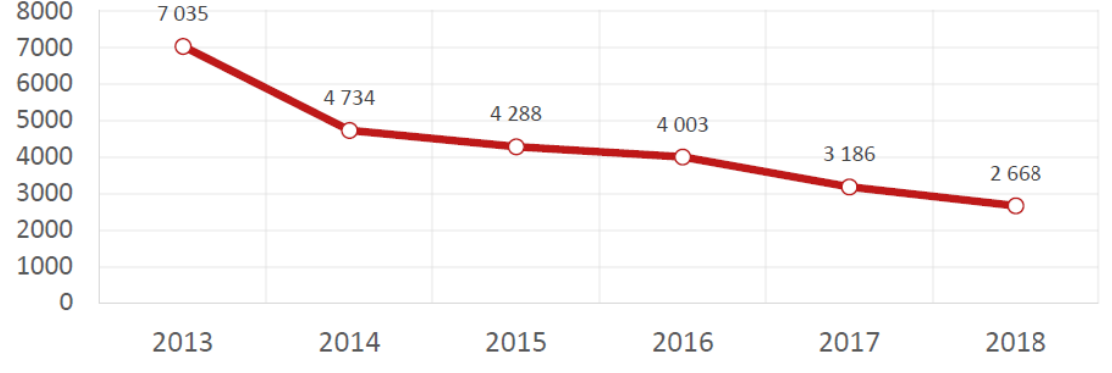
Figure 7: Decrease in the account of retained earnings SKANSKA (in CZK millions). (in millions of CZK), (source: Annual report of SKANSKA 2014-2018, data processed by the